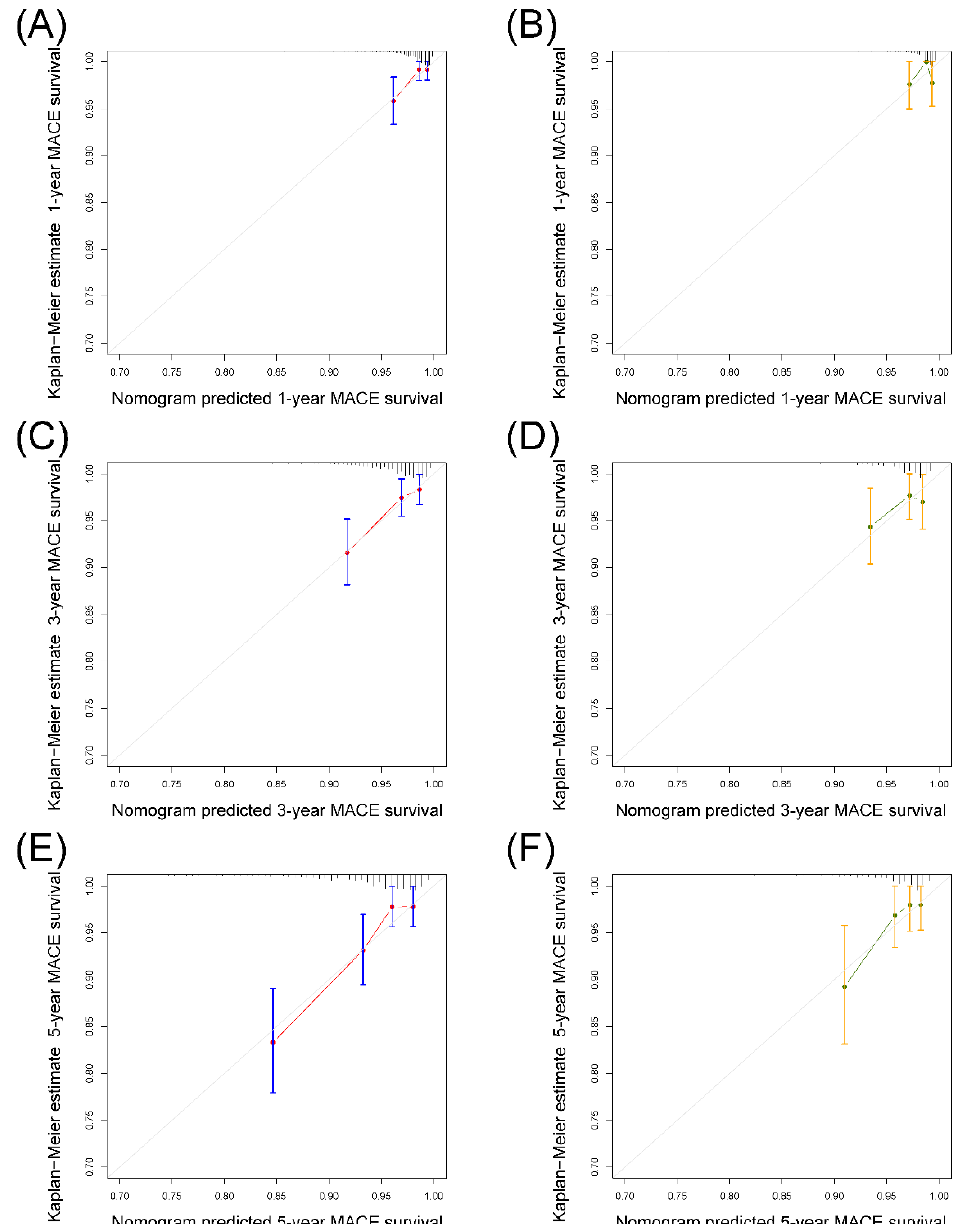
Figure 5. Calibration of the nomogram in derivation set and validation set. 1-year ( A , B ), 3-year ( C , D ) and 5-year ( E , F ) predictions. Data are from the derivation set ( A , C , E ) and validation set ( B , D , F ). This nomogram predicted cumulative incidence of MACE survival that were stratified in equally sized subgroups. For each subgroup, the average predicted MACE survival (nomogram-predicted MACE survival; x -axis) was plotted against the observed MACE survival Kaplan–Meier estimate MACE survival; y -axis). Vertical lines are 95% CIs of the MACE survival rate. Gray lines are the reference line, which would indicate where an ideal nomogram would lie.